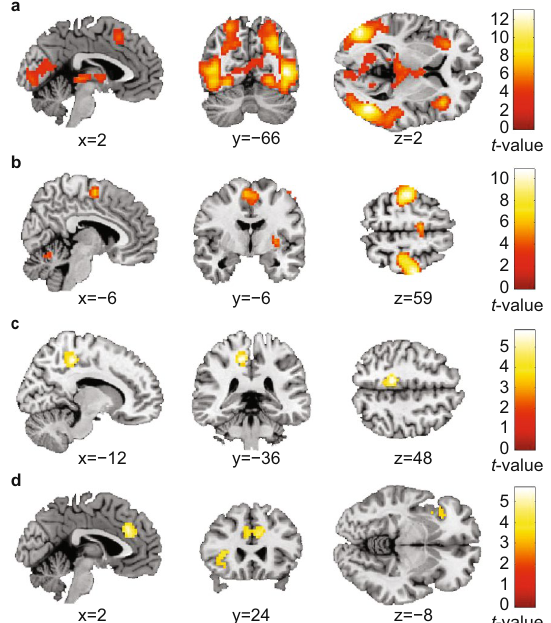
Figure 3. Main stop-signal task effects across subjects (n = 53) and measurements. Significant clusters at (whole-brain) pFWE < 0.05 are shown for the following contrasts: ( a ) StopSuccess > Go contrast (displayed at x = 2, y = − 66, z = 2); ( b ) Go > StopSuccess contrast (displayed at x = − 6, y = − 6, z = 59); ( c ) StopSuccess > StopFail contrast (displayed at x = − 12, y = − 36, z = 48). ( d ) StopFail > StopSuccess contrast (displayed at x = 2, y = 24, z = − 8). The cluster-defining threshold was set at p < 0.001 (uncorrected). The cluster extent was set at k > 55 to only show significant clusters (pFWE < 0.05, whole-brain). All mentioned coordinates are Montreal Neurological Institute (MNI) stereotaxic coordinates. The colour bars reflect peak t values. See Supplementary Table S5 for details per cluster. p FWE -value family-wise-error-corrected p